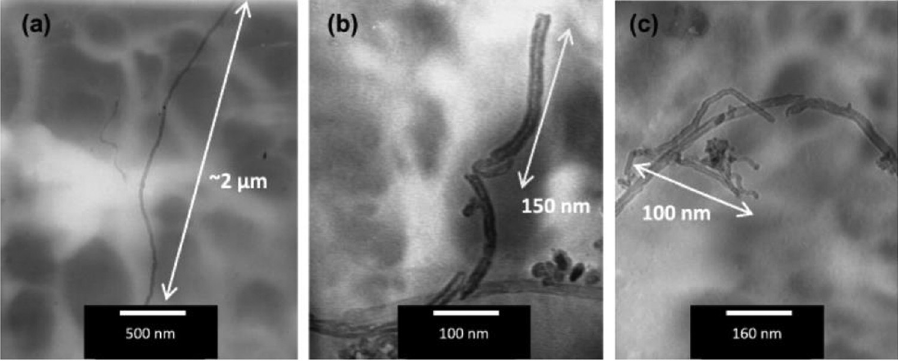
Figure 6: TEM images of MWCNT after di ff erent sonication energies: ( a ) 0 J, ( b ) 1,15,000, and ( c ) 1,70,000 J [ 82 ]